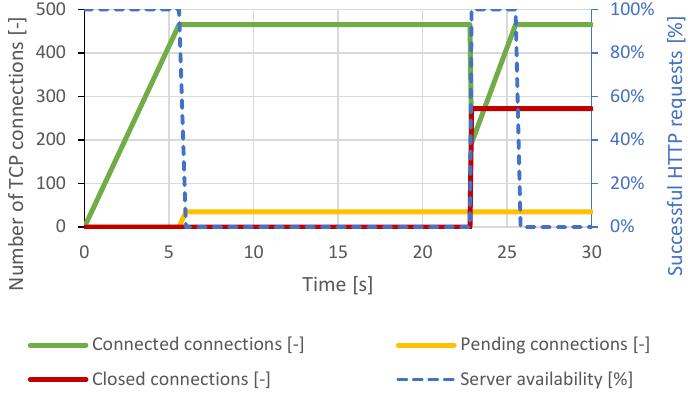
Figure 6. Slowcomm attack against Apache server.